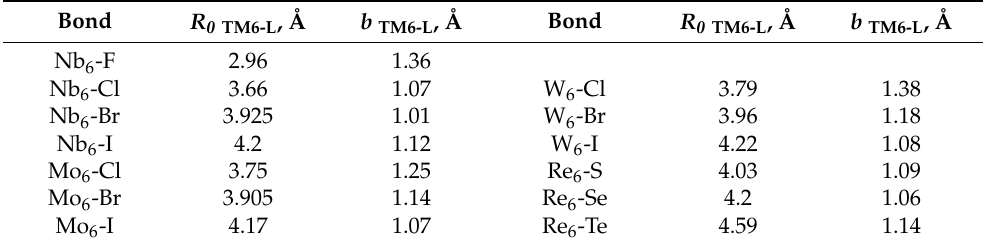
Table 2. Bond valence parameters for the TM 6 -anion pairs (TM 6 is a virtual cation located in the cluster